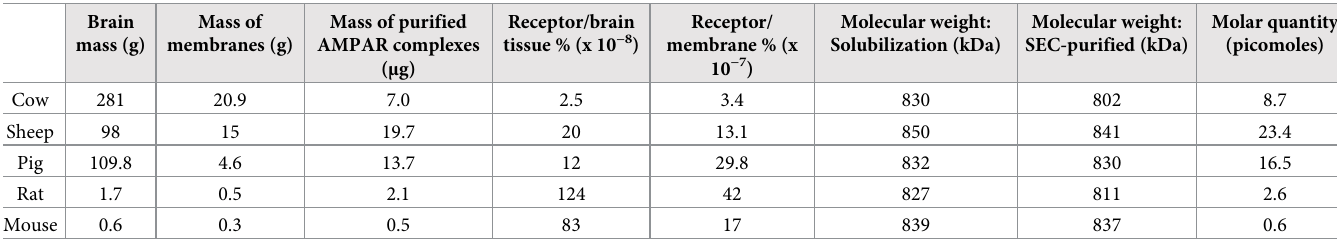
Table 1. Quantification of AMPARs and brain tissue amongst different species. Brain Mass of mass (g) membranes